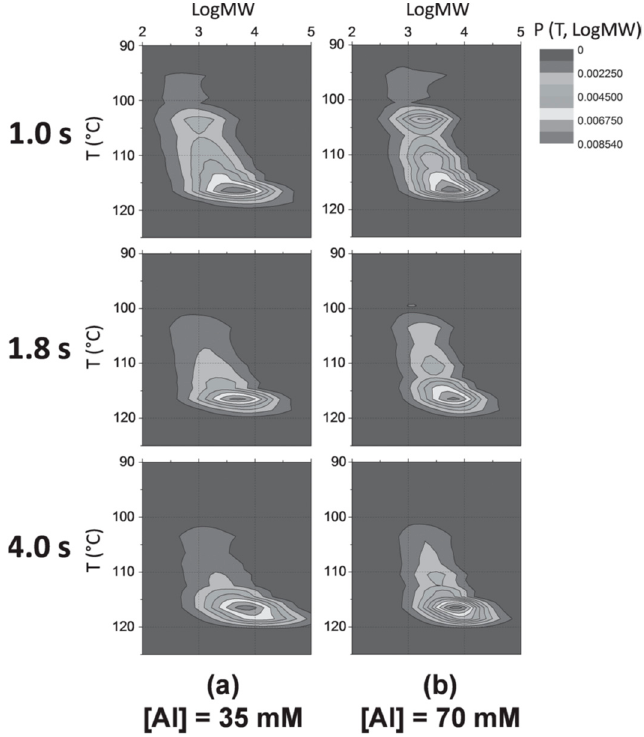
Figure 8. Cross fraction chromatography (CFC) contour plots of polymers obtained from LSF propylene polymerization at: ( a ) [Al] = 35 × 10 − 3 M; ( b ) [Al] = 70 × 10 − 3 M